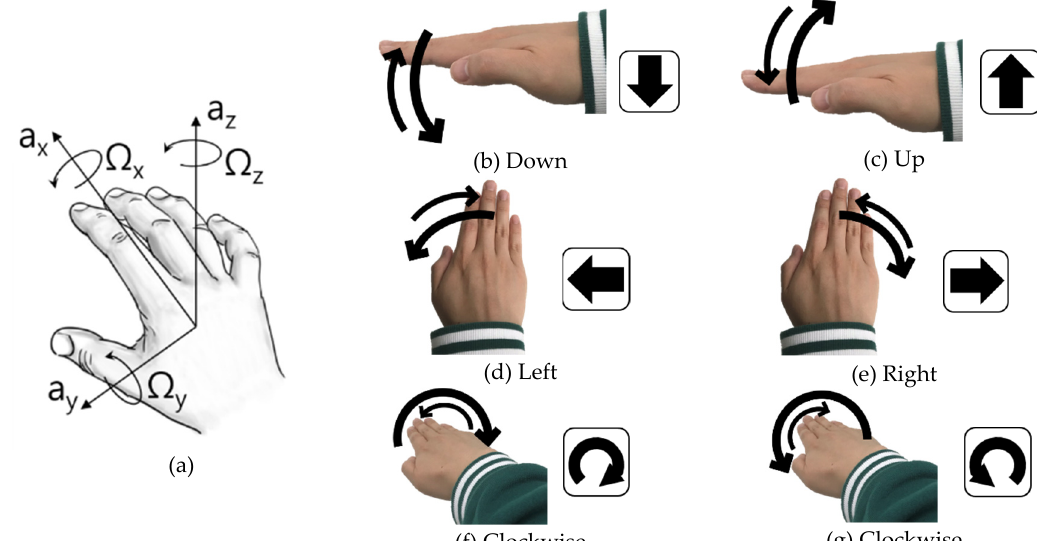
Figure 2. Six unit hand gestures selected based on user convenience. ( a ) The coordinate system and major directions of a wearable sensor mounted on a hand, ( b ) downward movement along the y -axis, ( c ) upward movement along the y -axis, ( d ) left directional movement along the z -axis, ( e ) right directional movement along the z -axis, ( f ) clockwise (CW) movement along the x -axis, and ( g ) counter clockwise (CCW) movement along the x -axis. Each thick arrow indicates the first motion direction and the thin arrow shows how the second (sequential) motion occurs to return to the neutral position.